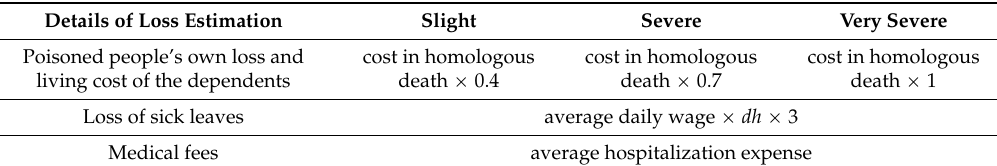
Table 2. The details of the loss estimation of one poisoned victim(unit: CNY).